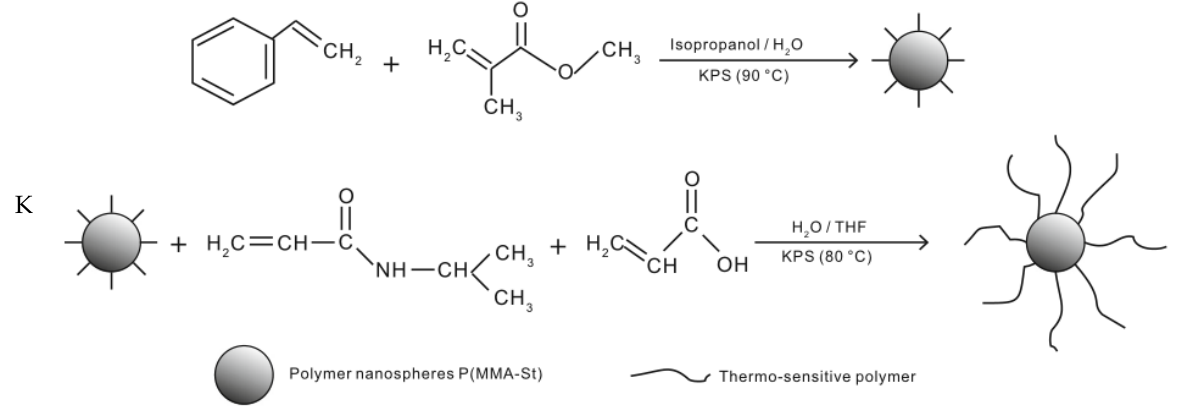
Figure 1. ( A ) Differential scanning calorimetric analysis curves of shape-memory polymers with different degrees of cross-linking [28]. ( B ) Shape recovery rate versus time for shape-memory polymers under different temperature conditions [28]. ( C ) Shape-memory plugging agent before and after activation under high temperature and pressure conditions. ( a ): Activated before; ( b ): After activation [28]. ( D ) Shape-memory epoxy resin synthesis reaction [31]. ( E ) SMP-LCM in different mesh ranges [31]. ( F ) Shape-memory epoxy foam expansion rate versus the temperature of different hollow glass bead dosage (curing agent dosage is 17%) [31]. ( G ) Cross-linking structure diagram [33]. ( H ) Synthesis of shape-memory epoxy foam [35]. ( I ) Status of the SMP-LCM in the depletion channel before and after the extension [35]. ( J ) Synthesis route of SD-SEAL nanoparticles [36]. ( K ) Diagram of SD ‐ SEAL physical blocking and chemical inhibition [36].